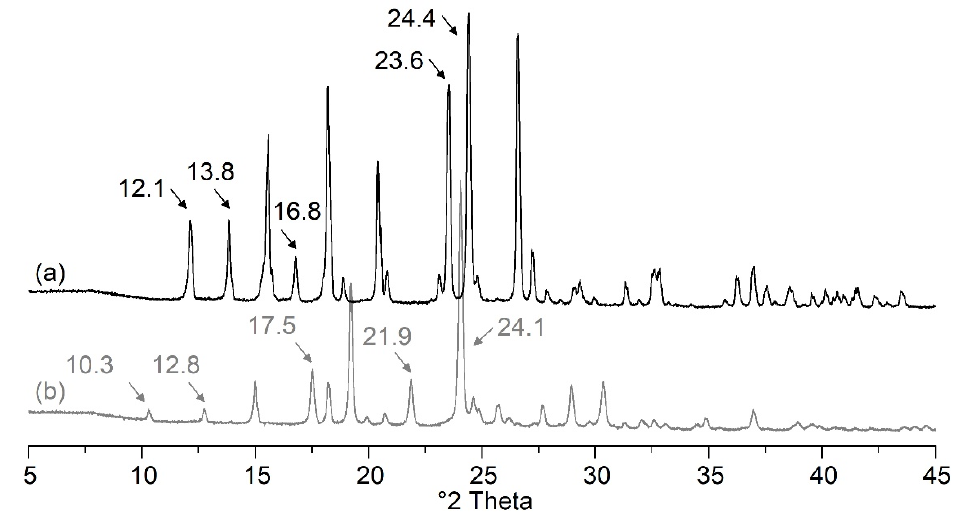
Figure 7. XRD diffractograms of PCM of different polymorphic forms. The arrows and numbers indicate the position of the characteristic diffraction peaks of each modification. ( a ) polymorphic form I, ( b ) polymorphic form II.